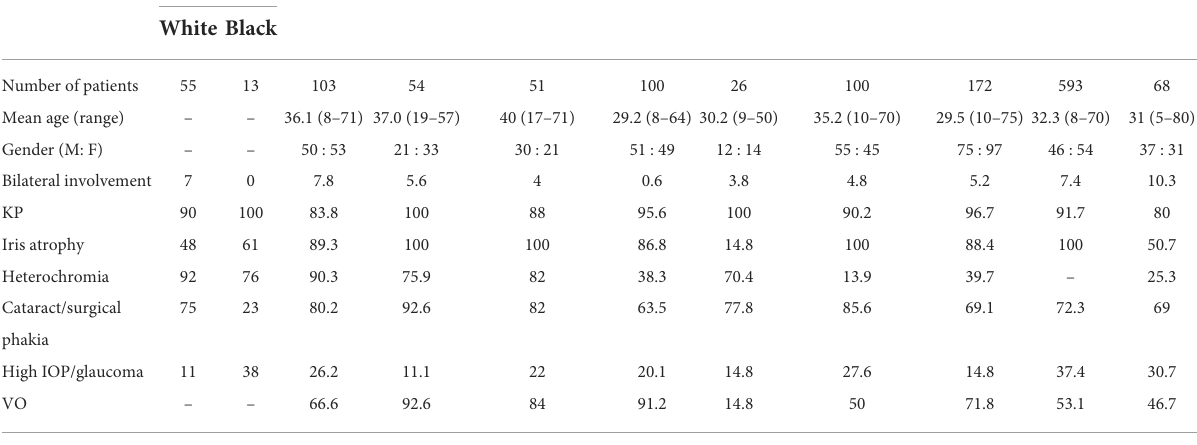
TABLE 4 Clinical findings in Fuchs’ uveitis syndrome reported by previous